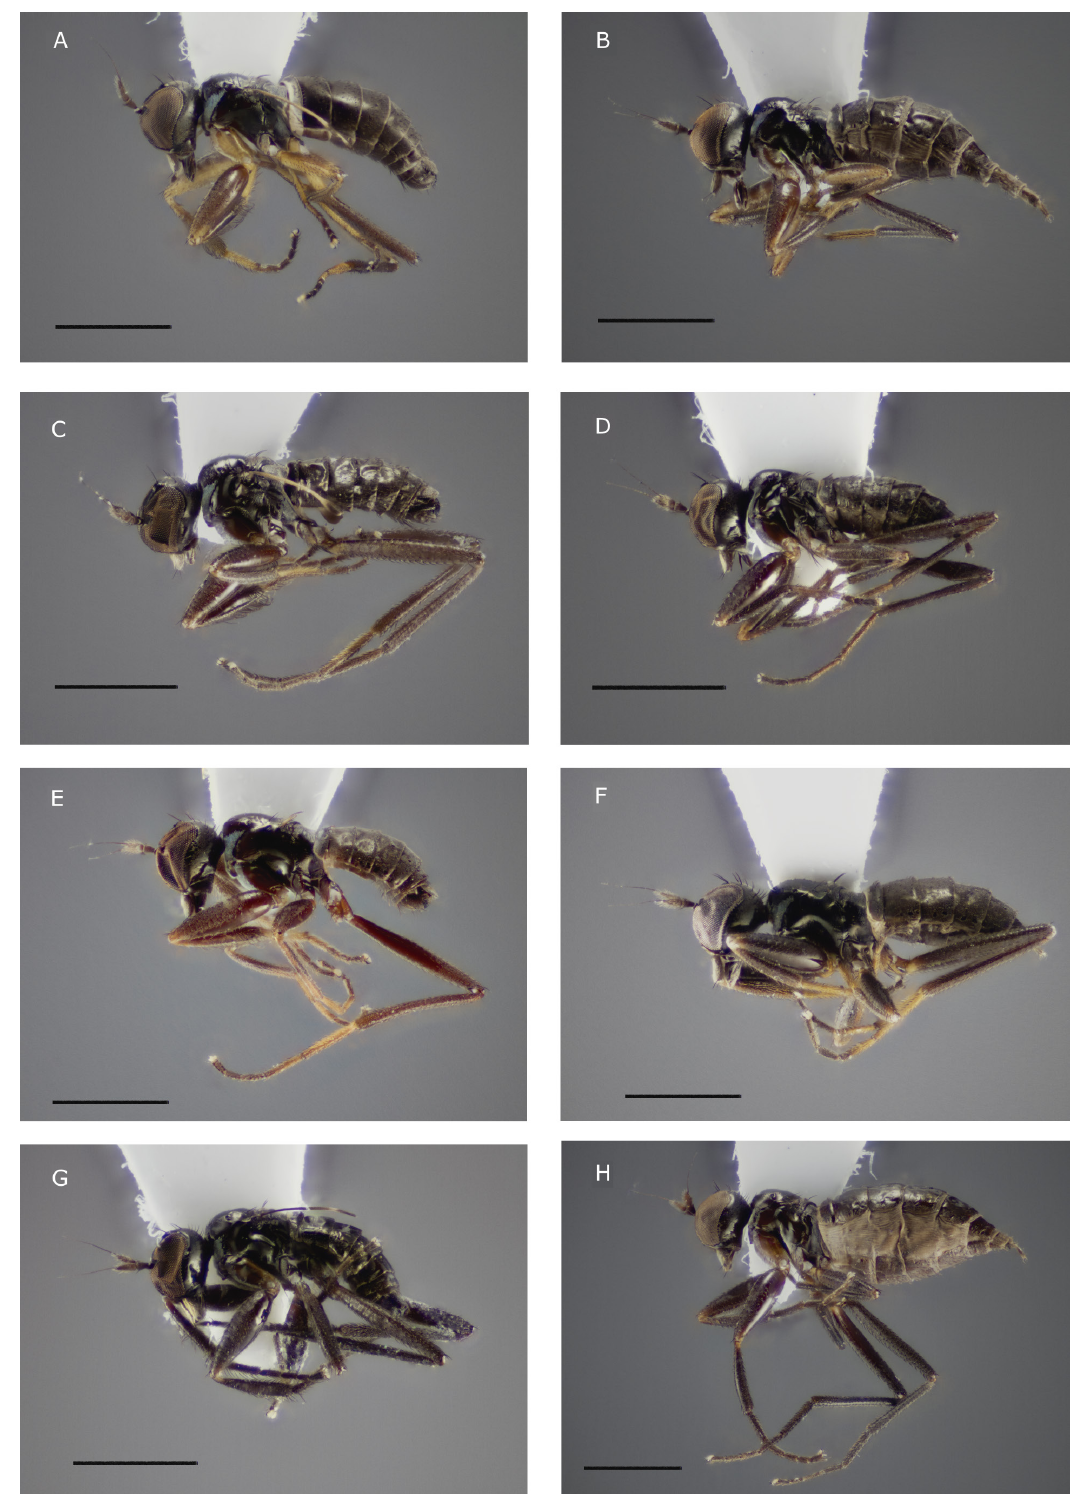
Fig. 17. Mounted specimens of the Iberian ant-like Tachydromia Meigen, 1803. Males are pictured in the left column, females in the right. A–B . T. lusitanica (Grootaert, Shamshev & Andrade, 2009). C–D . T. nigrohirta Gonçalves, Grootaert & Andrade sp. nov. E–F . T. ebejeri Gonçalves, Grootaert & Andrade sp. nov. G–H . T. stenoptera Gonçalves, Grootaert & Andrade sp. nov. Scale bars: